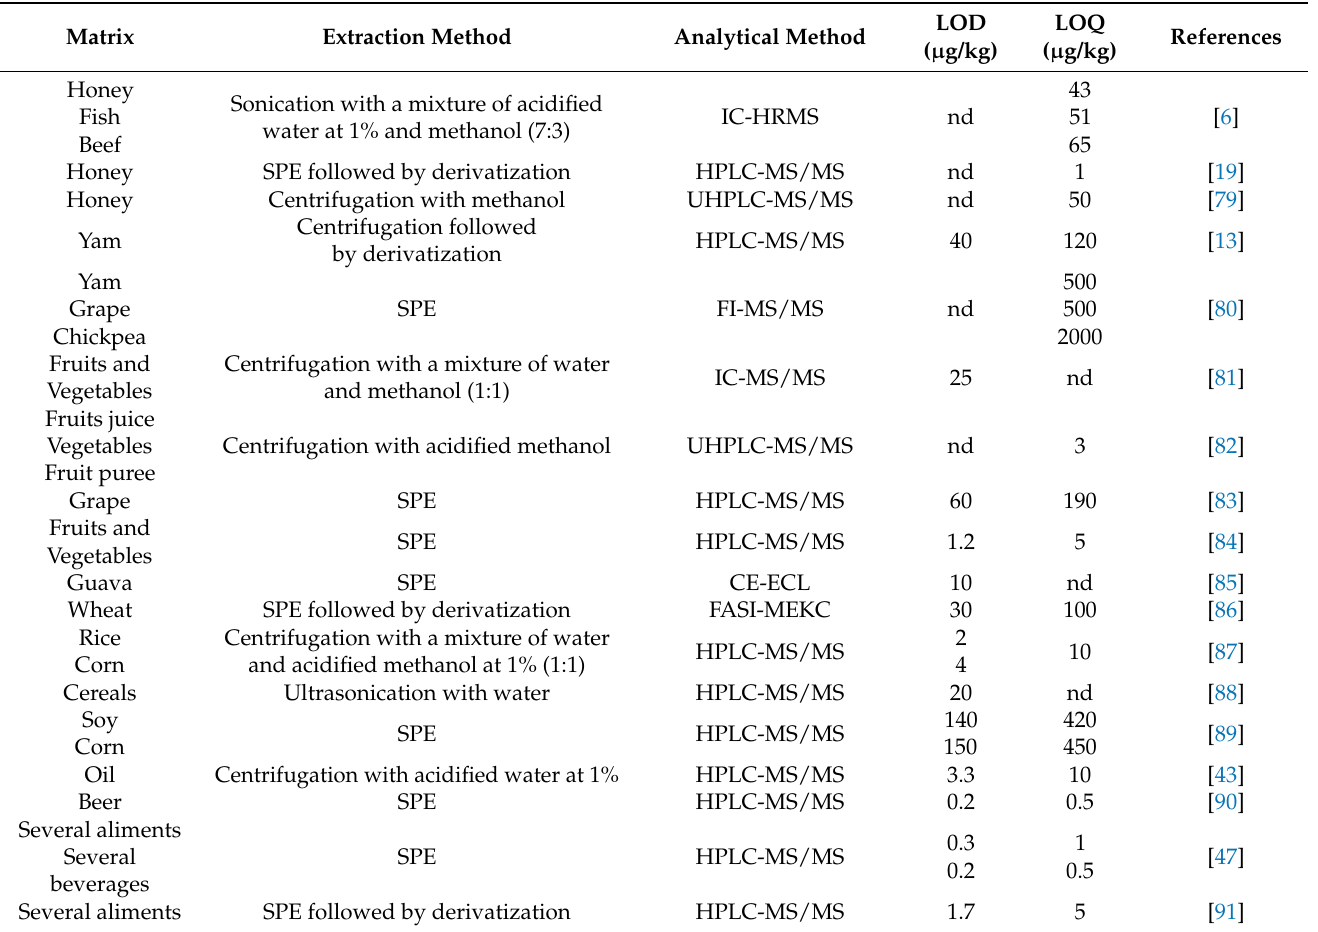
Table 3. Analytical methods used in glyphosate detection and